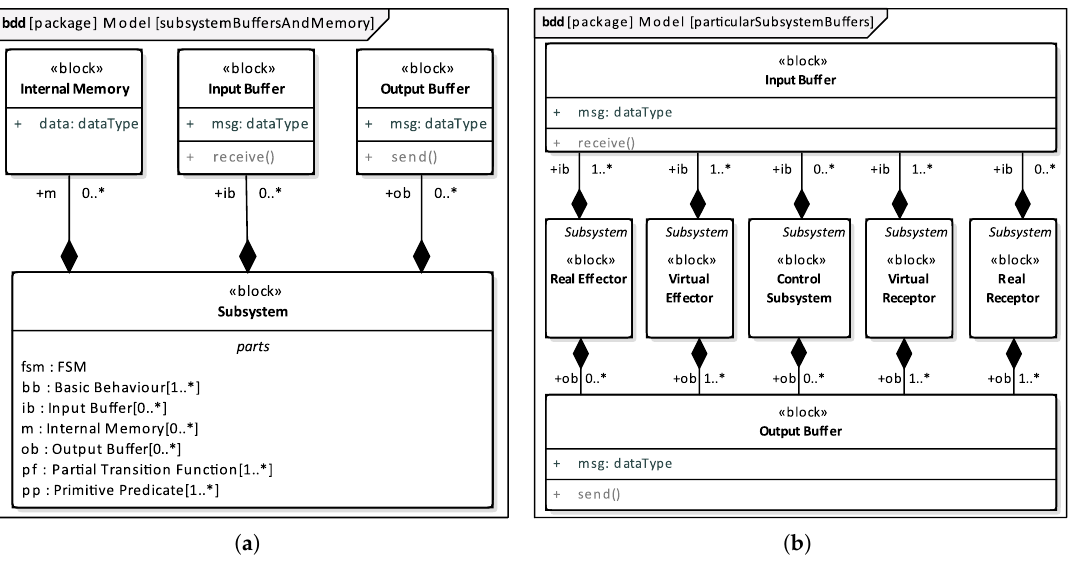
Figure 4. Subsystems and Buffers. ( a ) Subsystem Buffers and Internal Memory; ( b ) Relation of particular Subsystems to Communication